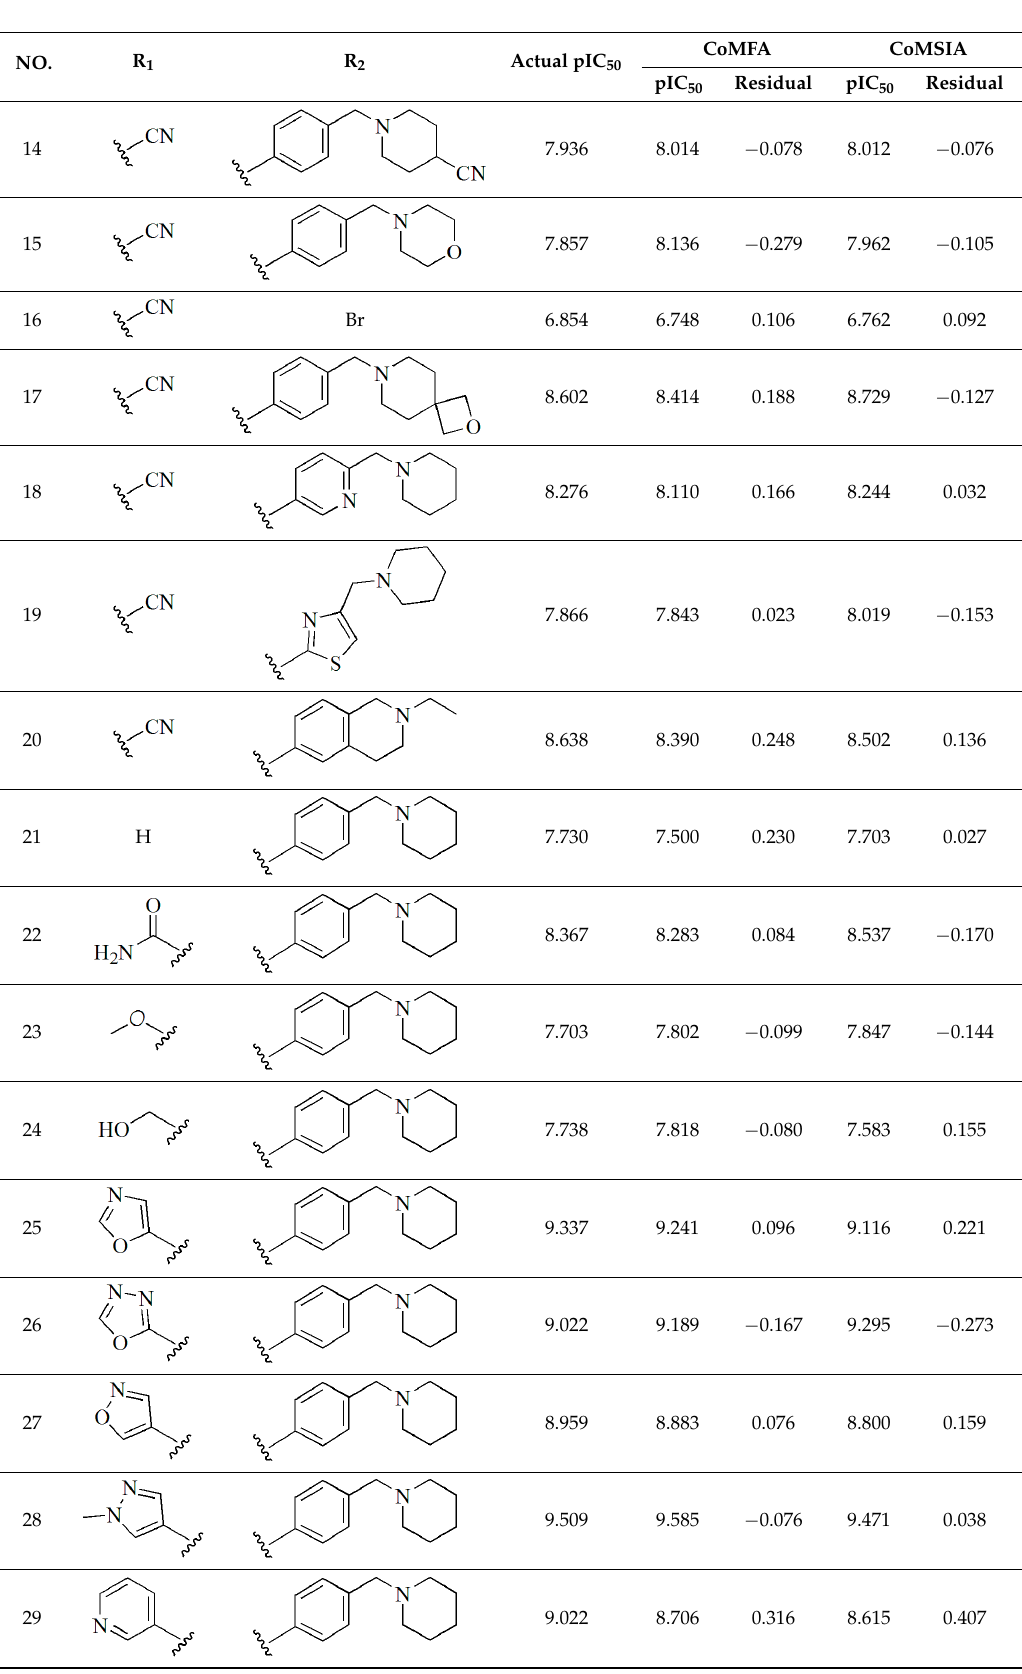
Table 1. Chemical structural formulas of all structures. Statistical parameters of the actual and predicted bioactivity by CoMFA and CoMSIA, as well as the residual between the actual and predicted pIC 50 values. All the aligned molecular dataset used for the 3D QSAR studies were shown in Table S1 in the supplementary materials